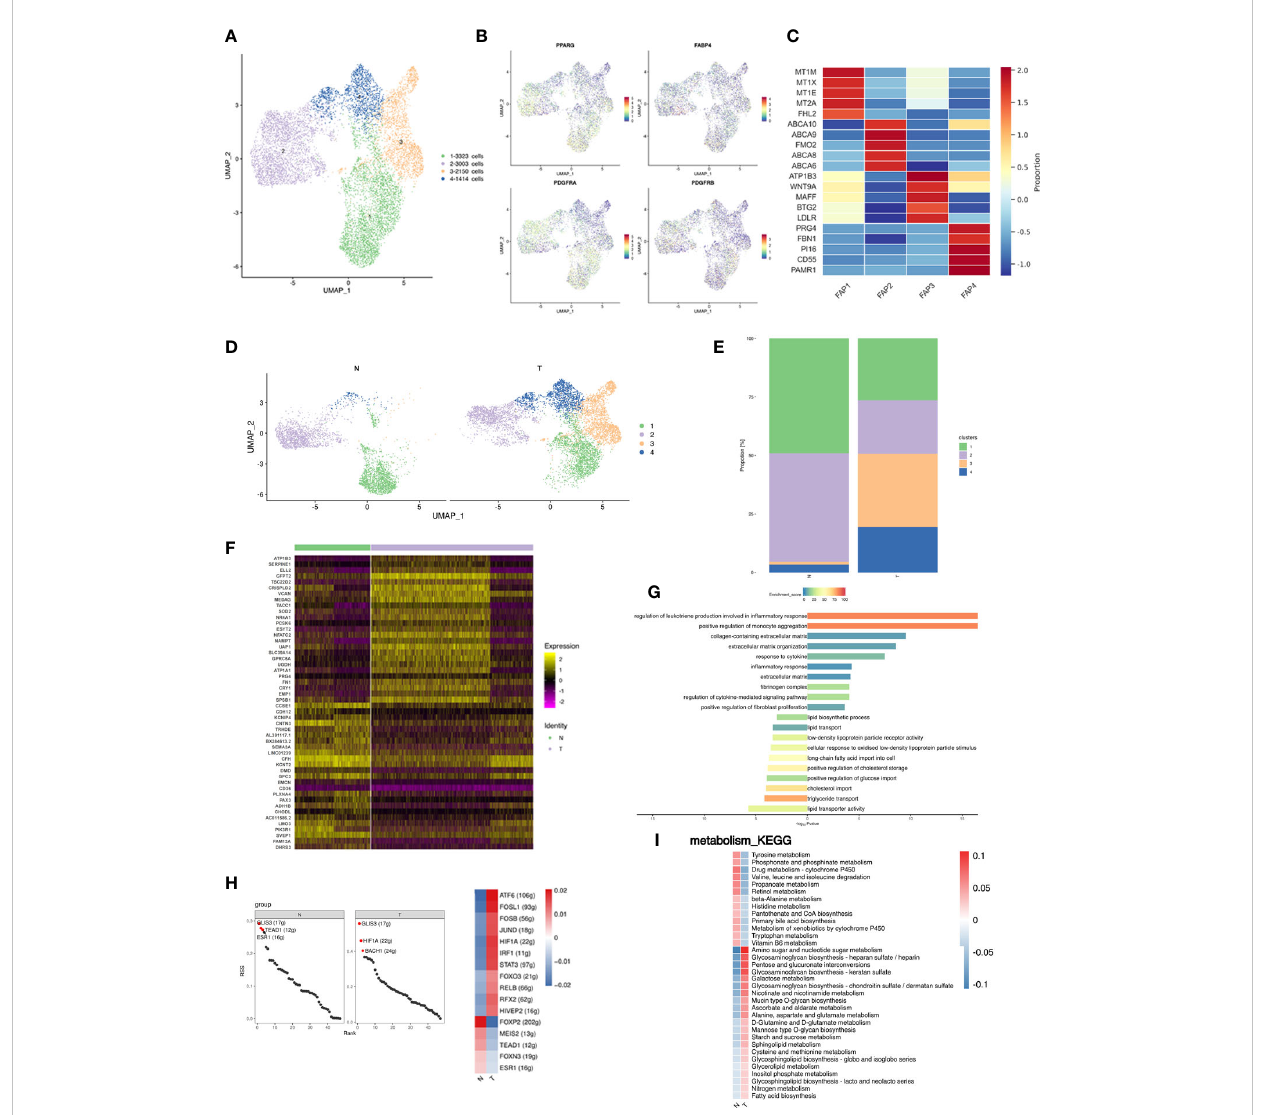
FIGURE 4 Fibro-adipogenic progenitors are shifted toward less adipogenic phenotype in breast cancer. (A) UMAP plot of 4 clusters of FAPs from the 6 samples pro fi led in this study, with each cell color coded to indicate the associated subclusters and cell numbers. (B) UMAP plot of preadipocyte marker genes PPARG, FABP4, PDGFRA and PDGFRB. (C) Heatmap showing the expression of FAP subpopulation marker genes in each cluster. The color changes from blue to red, indicating a low to high fold change. (D) UMAP plot of all FAP subpopulations annotated in each group with each cell color coded to indicate the associated subclusters. (E) The relative ratio of FAPs in N and T group shown using bar plots, with each cell color coded to indicate the associated subclusters. (F) Heatmap showing the top 25 differential expression analysis of genes (up- or down-regulated). The color changes from blue to red, indicating a low to high fold change. (G) Barplot showing the signi fi cance levels of the top 10 most signi fi cantly enriched pathways in all DEGs. The left side of the coordinate axis represents the enriched functional pathway of down-regulated genes; The right side of the coordinate axis represents the enriched functional pathway of up-regulated genes. (H) The regulon speci fi city score (RSS) ranking plot of top 3 TFs in N and T group. The abscissa represents the ranking, and the ordinate represents the RSS score. The regulator with higher RSS may be related to the speci fi city of this cell group (upper). Heatmap showing the regulon activity in N and T group. Rows represent different regulons, and columns represent different cell populations. The color changes from blue to red, indicating a low to high RSS speci fi city score. The higher the RSS score, the stronger the speci fi city of regulon in this cell group (lower). The number of target genes shown in brackets. (I) Heatmap indicating the enrichment of metabolism signaling pathway on all FAPs in N and T